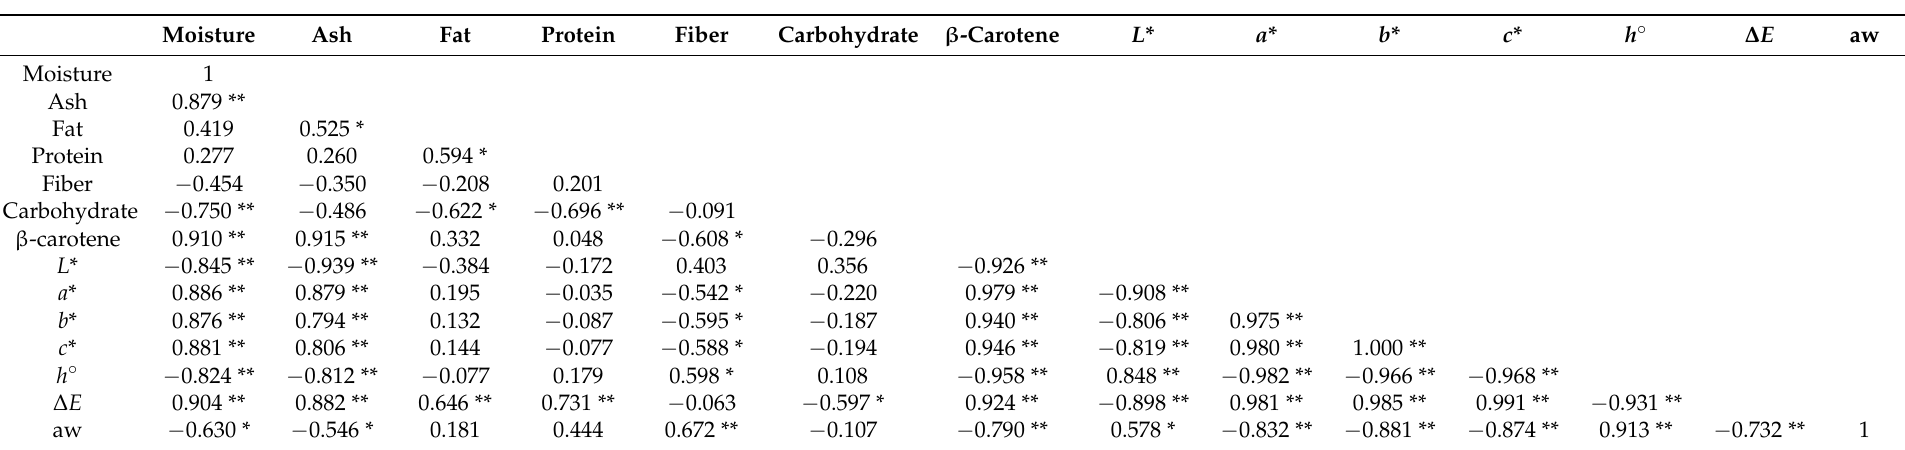
Table 6. Pearson correlation coefficients among physical and chemical attributes of